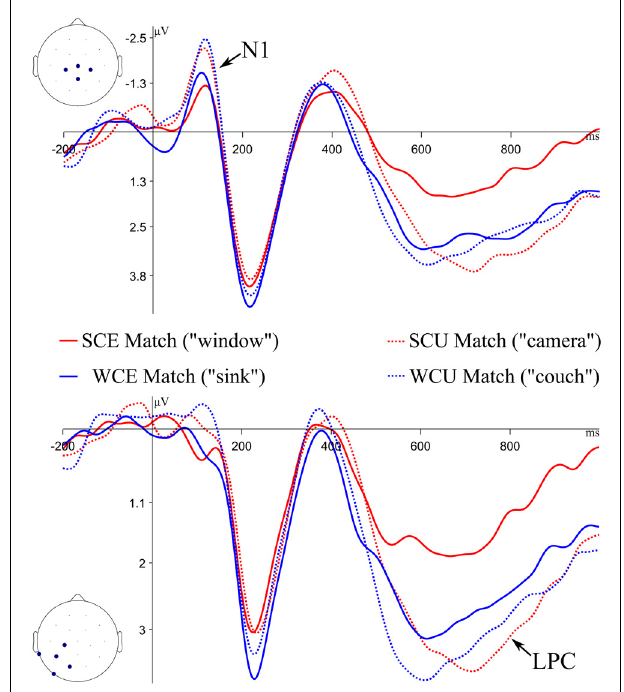
memory test. ERPs plotted at the Central Cluster (top of figure) and the Left Parietal Cluster (bottom of figure). SC, strong constraint (“Tim threw a rock and broke the ... ”); WC, weak constraint (“His ring fell into a hole in the ... ”); E, expected; U, unexpected. In quotations are example stimuli, based on examples from Table 1 .